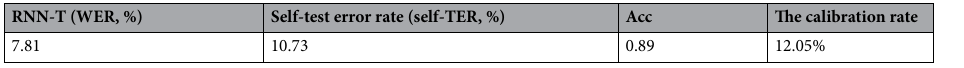
Table 3. Performance measurement table for the dual detection model in the paper. RNN-T (WER, %) refers to the word error rate of end-to-end speech recognition speech-to-text conversion of RNN-T; self-test match (self-cm) refers to the difference quotient of scores after the dual subject-objective test and the seafarer mental health test SMHT only. The self-test process is somewhat personal and subjective, so the data may have slight